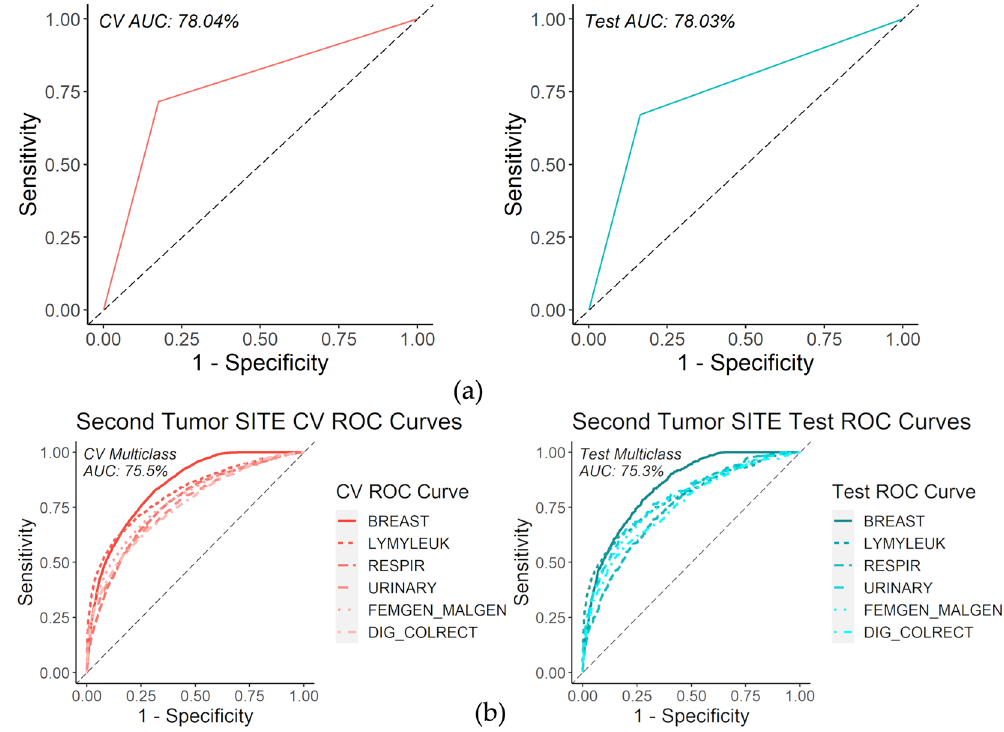
Figure 6. ( a ) Site specific vs non site specific ROC curve example. CV curve (left) and test curve (right); ( b ) Second tumor site ROC curve example. CV curve (left) and test curve